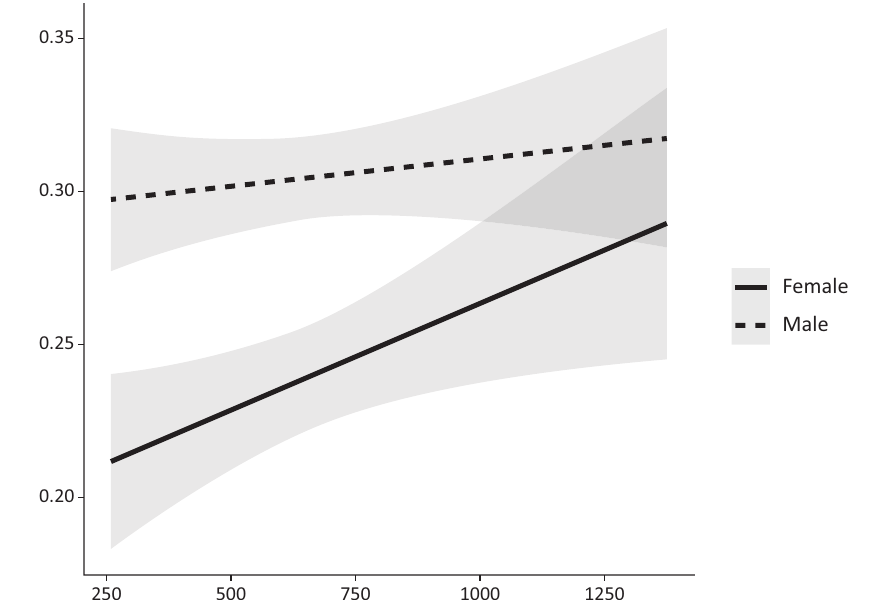
Figure 2. Predicted marginal effects of media coverage on social media use by gender (with 95% confidence